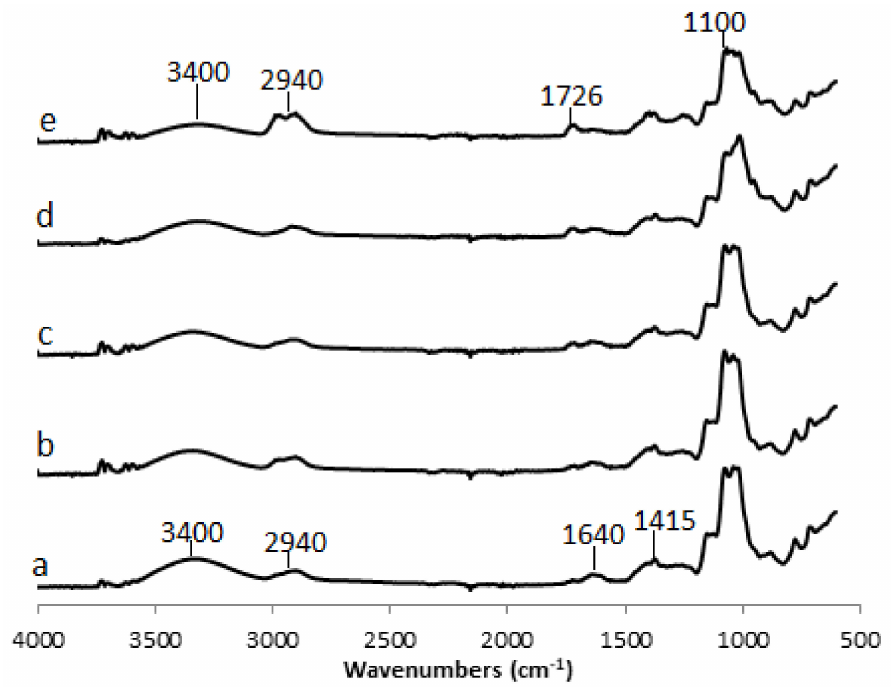
Figure 5. FTIR spectra for CG–OSA adducts from the bottom to the top: a ) sample O1, b ) sample O2, c ) sample O3, d ) sample O4, and e ) sample